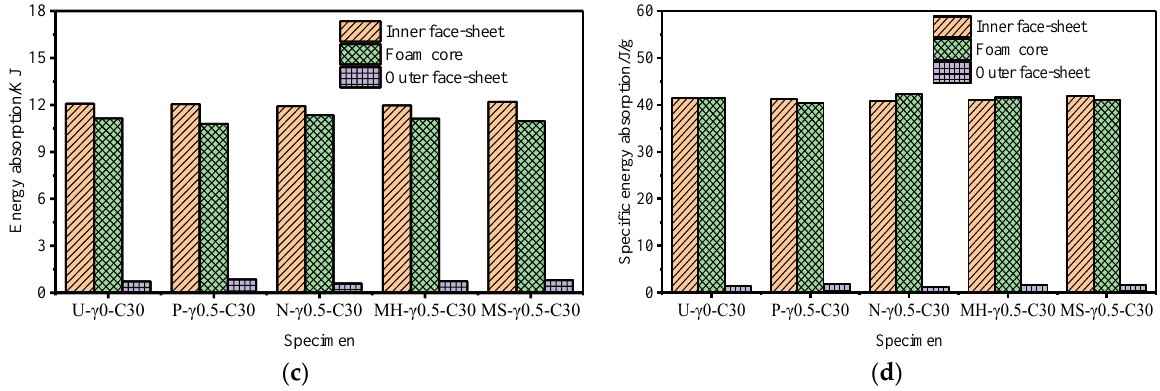
Figure 13. Anti − explosion performance of a foamed aluminum sandwich tube when the core density gradient is 0.5. ( a ) Deformation curve of the inner tube, ( b ) deformation curve of the outer tube, ( c ) total energy absorption of the sandwich tube, and ( d ) specific energy absorption of the sandwich tube.